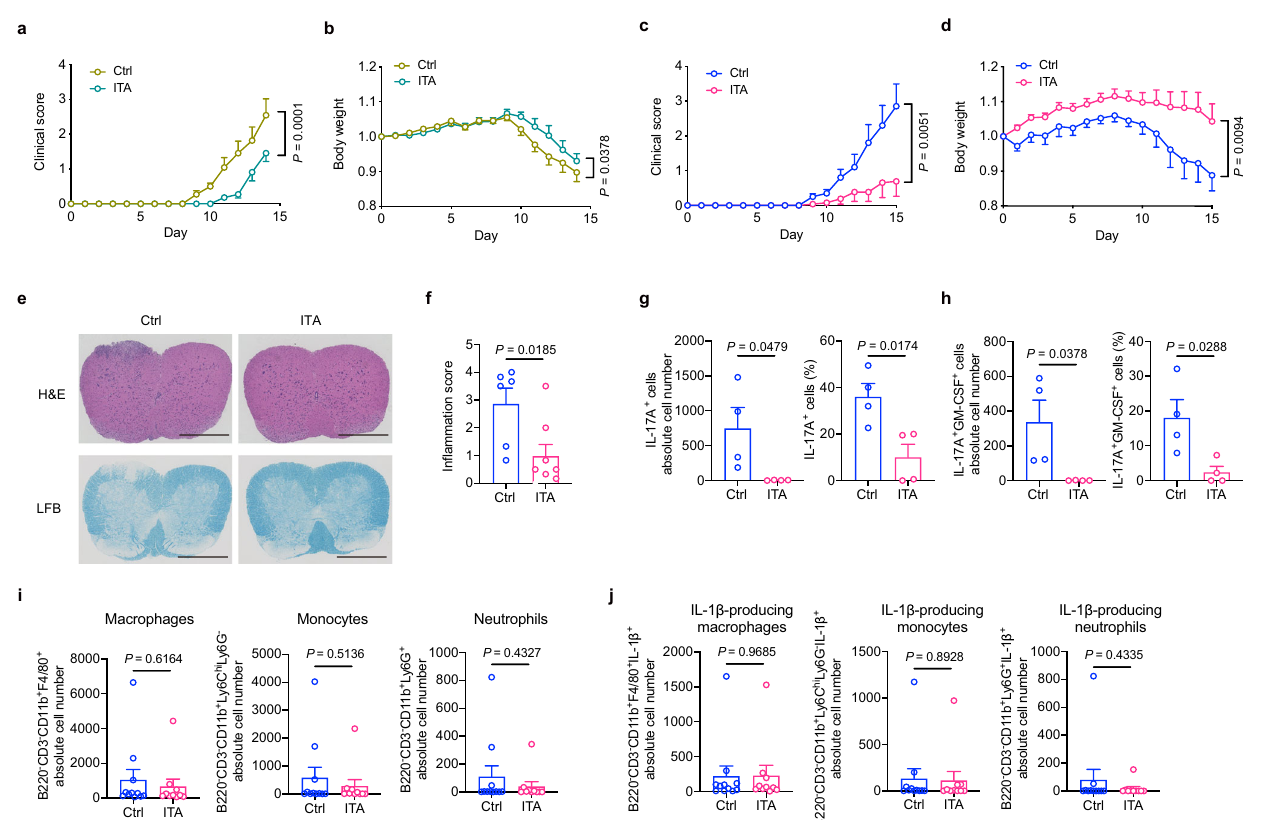
Fig. 2 | Itaconate ameliorates experimental autoimmune encephalomyelitis. a , b C57BL/6J mice were immunized with myelin oligodendrocyte glycoprotein (MOG) 35-55 and complete Freund ’ s adjuvant (CFA). Mice were intraperitoneally injected with 50mgkg − 1 itaconate (ITA) every other day from day 0 to day 14. Clinicalscores( a )and bodyweight( b )inEAEmicetreated withPBS (Ctrl, n =11)or ITA ( n =11). c – j For adoptive transfer EAE (tEAE), pathogenic Th17-polarizing CD4 + T cells from 2D2 mice were cultured with or without ITA ex vivo for 3 days. Then, theharvestedcellsweretransferredtorecipient Rag1 -de fi cientmiceintravenously. Clinical scores ( c ) and body weight ( d ) of control (Ctrl, n =10) or ITA ( n =13) reci- pient mice in tEAE models. e Representative histology of spinal cord stained with hematoxylin and eosin (H&E) and luxol fast blue (LFB). Scale bar, 500 μ m. f In fl ammation scores of spinal cords are shown (Ctrl, n =6; ITA, n =8, biologically